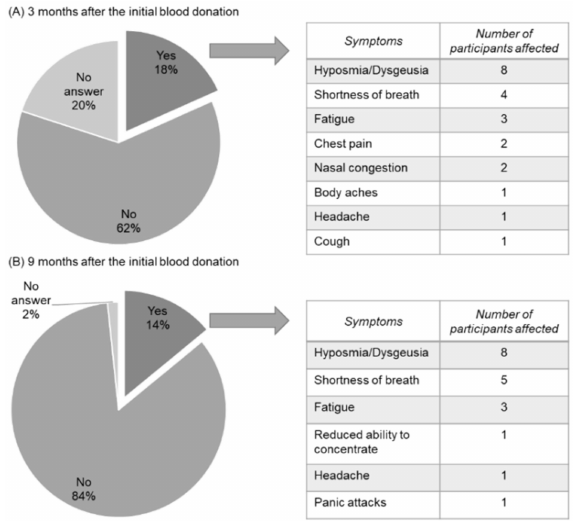
Figure 8. Long-term COVID-19-related symptoms among blood donors. ( A ) Three months after blood donation, 18% of the study participants reported suffering from symptoms related to a previous SARS-CoV-2 infection. This number decreased to 14% nine months after the initial blood donation ( B